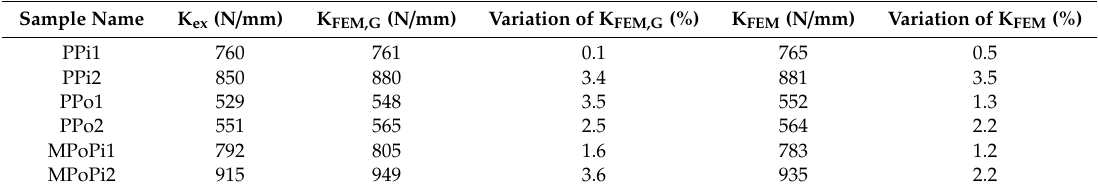
Experimental and numerical sti ff ness used for the calibration of the FEM model. sti ff ness without using G. Variation in % computed respect to K